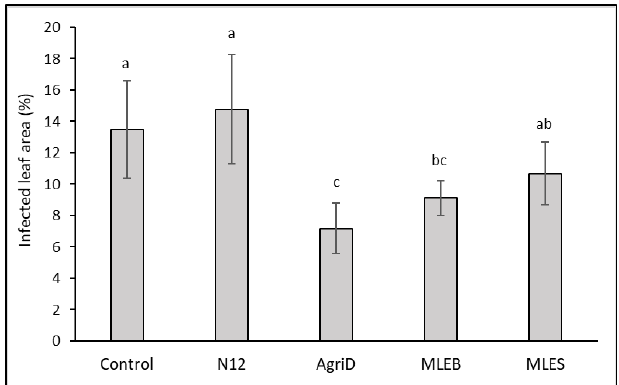
Figure 6. Effect of biostimulant application on infected area (%) of lettuce leaves following Botrytis cinerea infection. Different letters indicate significant differences according to Fisher ’s test ( p ≤ 0.05).